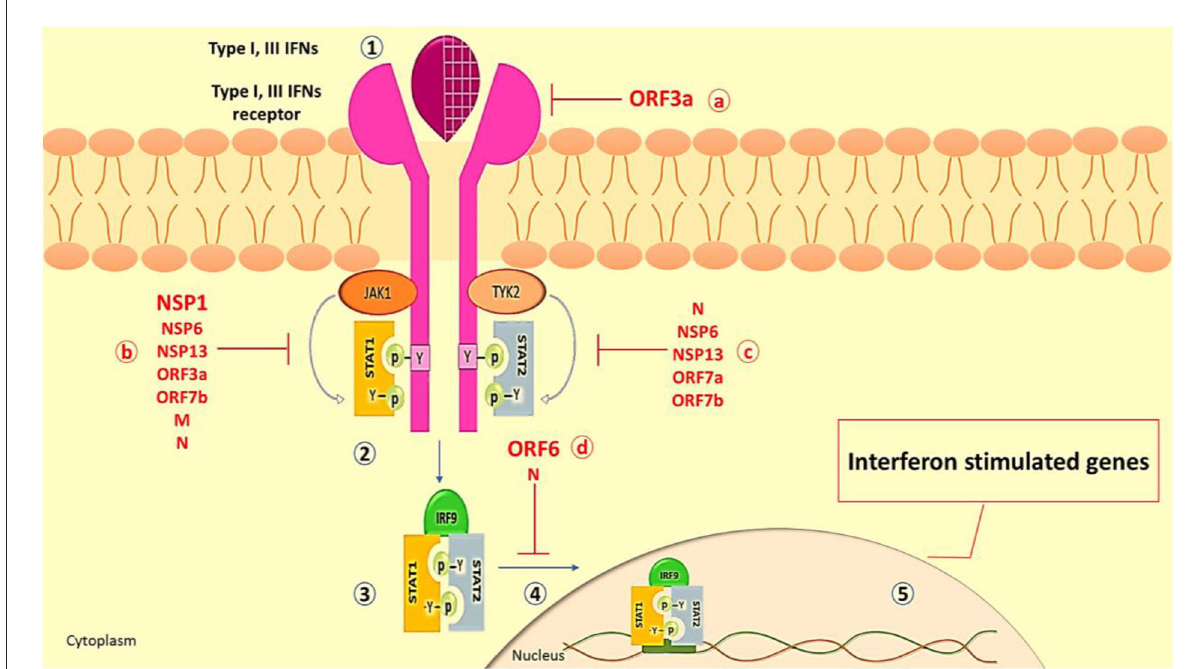
FIGURE3 The Interferon type I and III canonical signaling pathway. (1) Type I and III IFNs (e.g., IFN- α , IFN- β , IFN- λ ) released from virus-infected cells bind to their receptors (e.g., IFNA/LR) on neighboring cells, leading to the dimerization of receptors and activation of JAK1 and TYK2. (2) The activated JAK1 and TYK2 phosphorylate the tyrosine residue of the IFN receptor which recruits various members of the STAT family as STAT 1 and STAT2. Also, JAK1 and TYK2 add phosphorus to recruit STATs and activate them. (3) Following separation from the receptor, STAT1/STAT2 dimer interacts with IRF9. (4) The STAT1/STAT2/IRF9 complex moves to the nucleus. (5) Placement of the complex on its promoter on the gene leads to the robust expression of many classical IFN-stimulated genes (ISGs, such as ISG15, MxA, IFITM, etc.), which exert an antiviral role to restrict viral replication and spreading (109). SARS-CoV-2 inhibits IFN production and response through a variety of methods. As a result, target cells close to the original infection fail to receive essential and protective IFN signals, allowing the virus to propagate. The ORF3a can inhibit type III IFN receptors. The structural proteins of SARS-CoV-2, N, and M, and nonstructural proteins such as NSP1, NSP6, NSP13, ORF3a, and ORF7b quench IFN signaling by inhibition of STAT1 phosphorylation. (c) The phosphorylation of STAT2 in COVID-19 is repressed by N, NSP6, NSP13, ORF7a, and ORF7b proteins. (d) The translocation of the STAT1/STAT2/IRF9 into the nucleus is inhibited by N and ORF6 proteins which attenuate the transcription of the interferon-stimulated gene (13, 110, 111). IFN, Interferon; ISG, Interferon Stimulated Gene; STAT, Signal Transducer and activator of Transcription; IRF9, Interferon Regulatory Factor 9; TYK2, Tyrosine Kinase 2; JAK, Janus Kinase; MxA, Myxovirus Resistance Gene A; IFITM, Interferon Induced Transmembrane; OFR, Open Reading Frame; NSP, None Structural